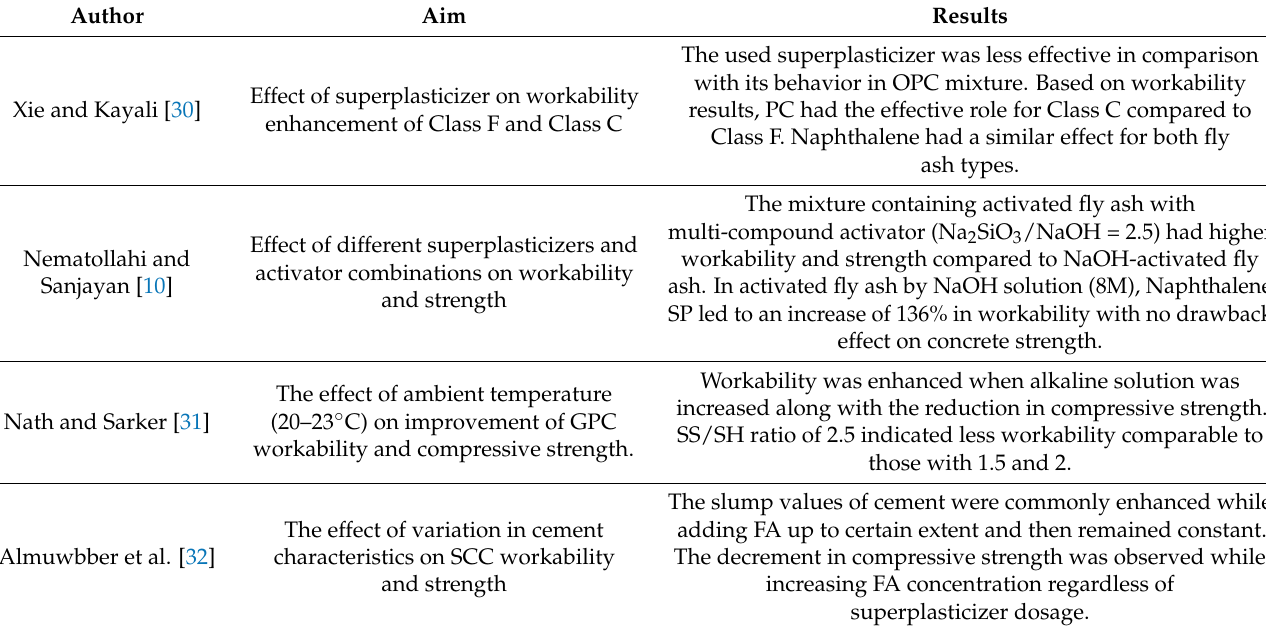
Table 2. Effective factors on the improvement of GPC properties and